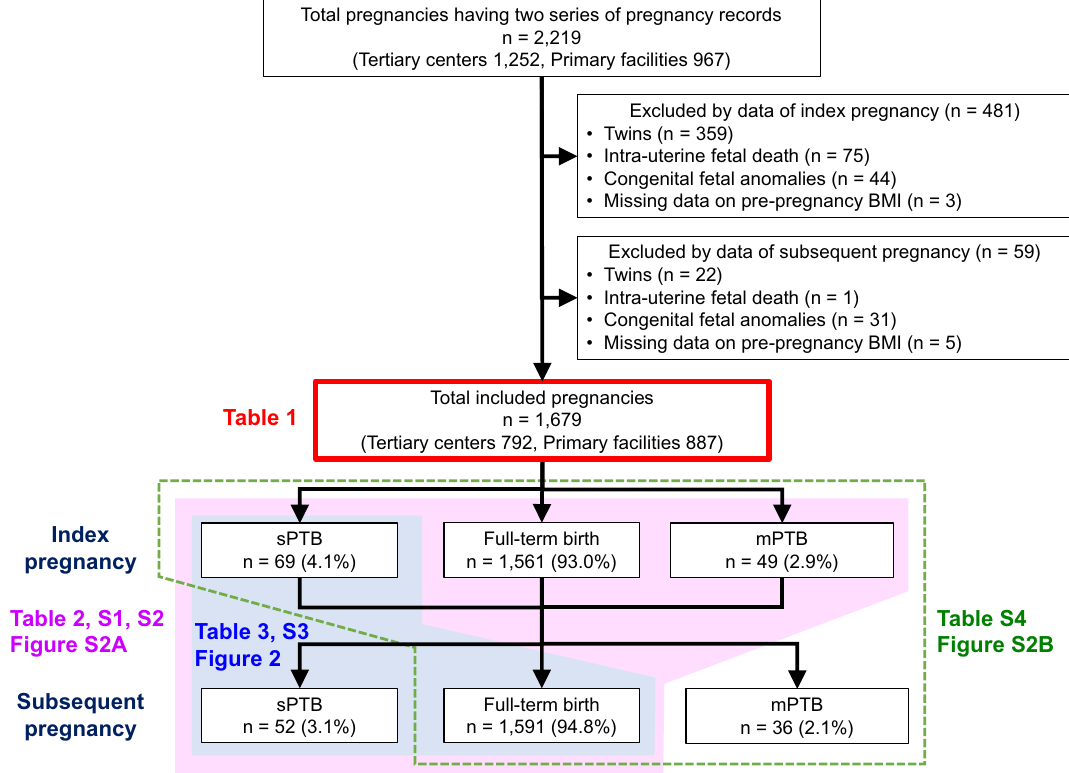
Figure 1. Flow chart of the study subjects. Clinical data were obtained from 2,219 individuals who gave birth twice at tertiary centers (n = 2) or primary maternity care units (n = 12). A total of 1679 individuals were eligible for this study, after the exclusion of 481 and 59 individuals based on their index and subsequent pregnancy data, respectively. BMI, body mass index; sPTB, spontaneous preterm birth; mPTB, medically indicated preterm